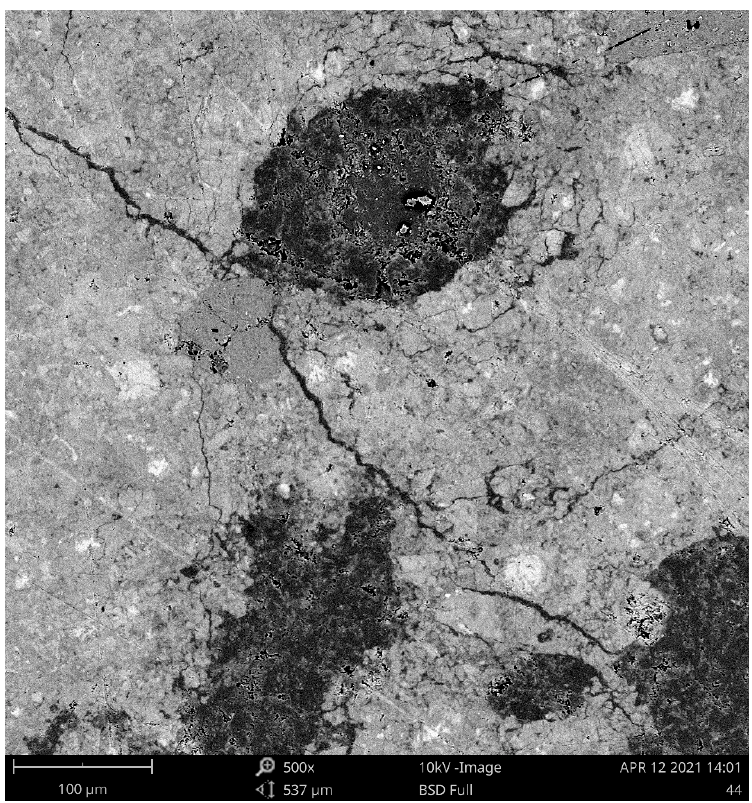
Figure 2. SEM image of SAP particles embedded in a mortar structure (A3 mixture).